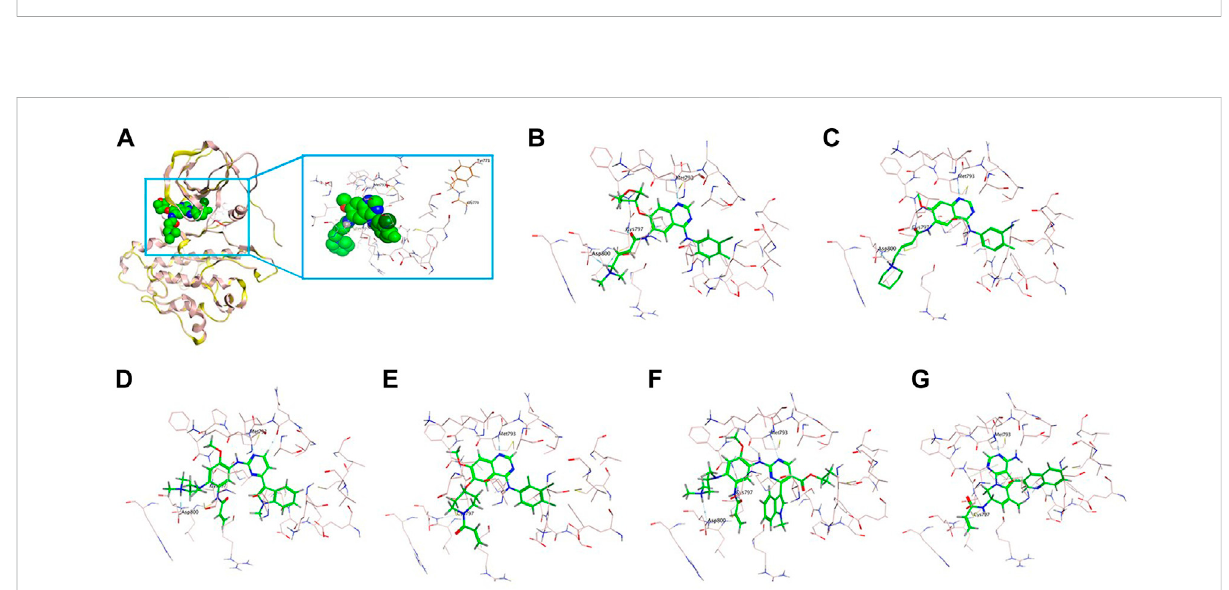
FIGURE 3 3D-basedstructureofG770delinsGYvariant (A) withthebindingpocket(markedinpink)ofacertaininhibitor(markedingreen)andtheinserted amino acids GY (marked in brown). Binding modes of diverse EGFR TKIs including afatinib (B) , dacomitinib (C) , osimertinib (D) , poziotinib (E) , mobocertinib (F) and CLN-081 (G) for the D770delinsGY